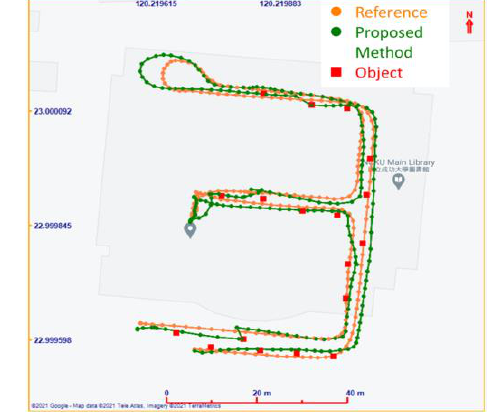
Figure 14 . The trajectory of proposed integration scheme